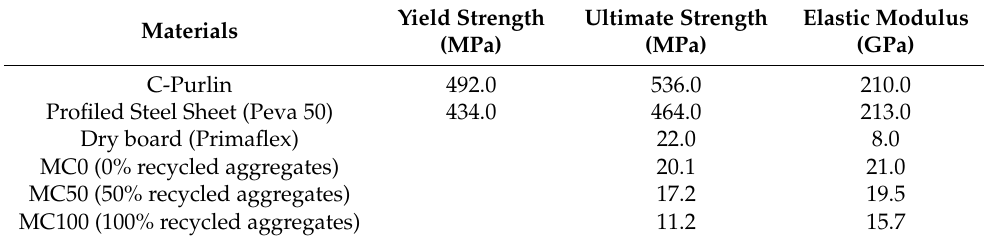
Table 3. Physical properties of the tested materials.